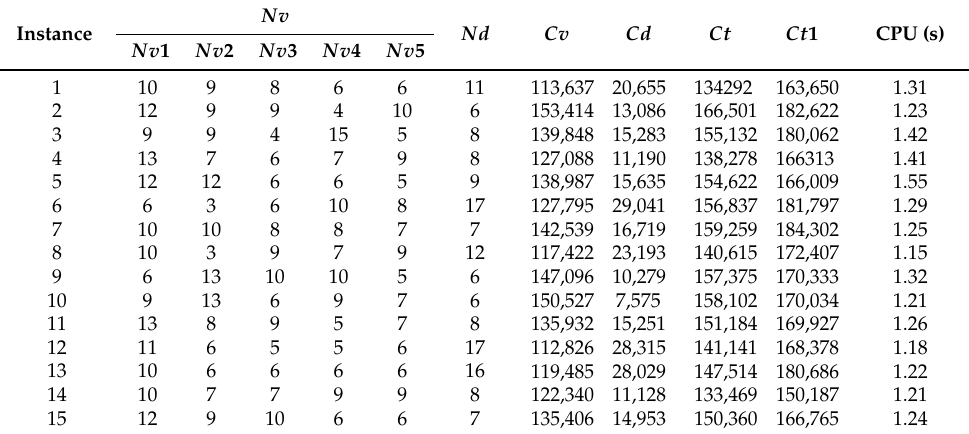
Table 1. Heuristic solutions for the 50-node instances.